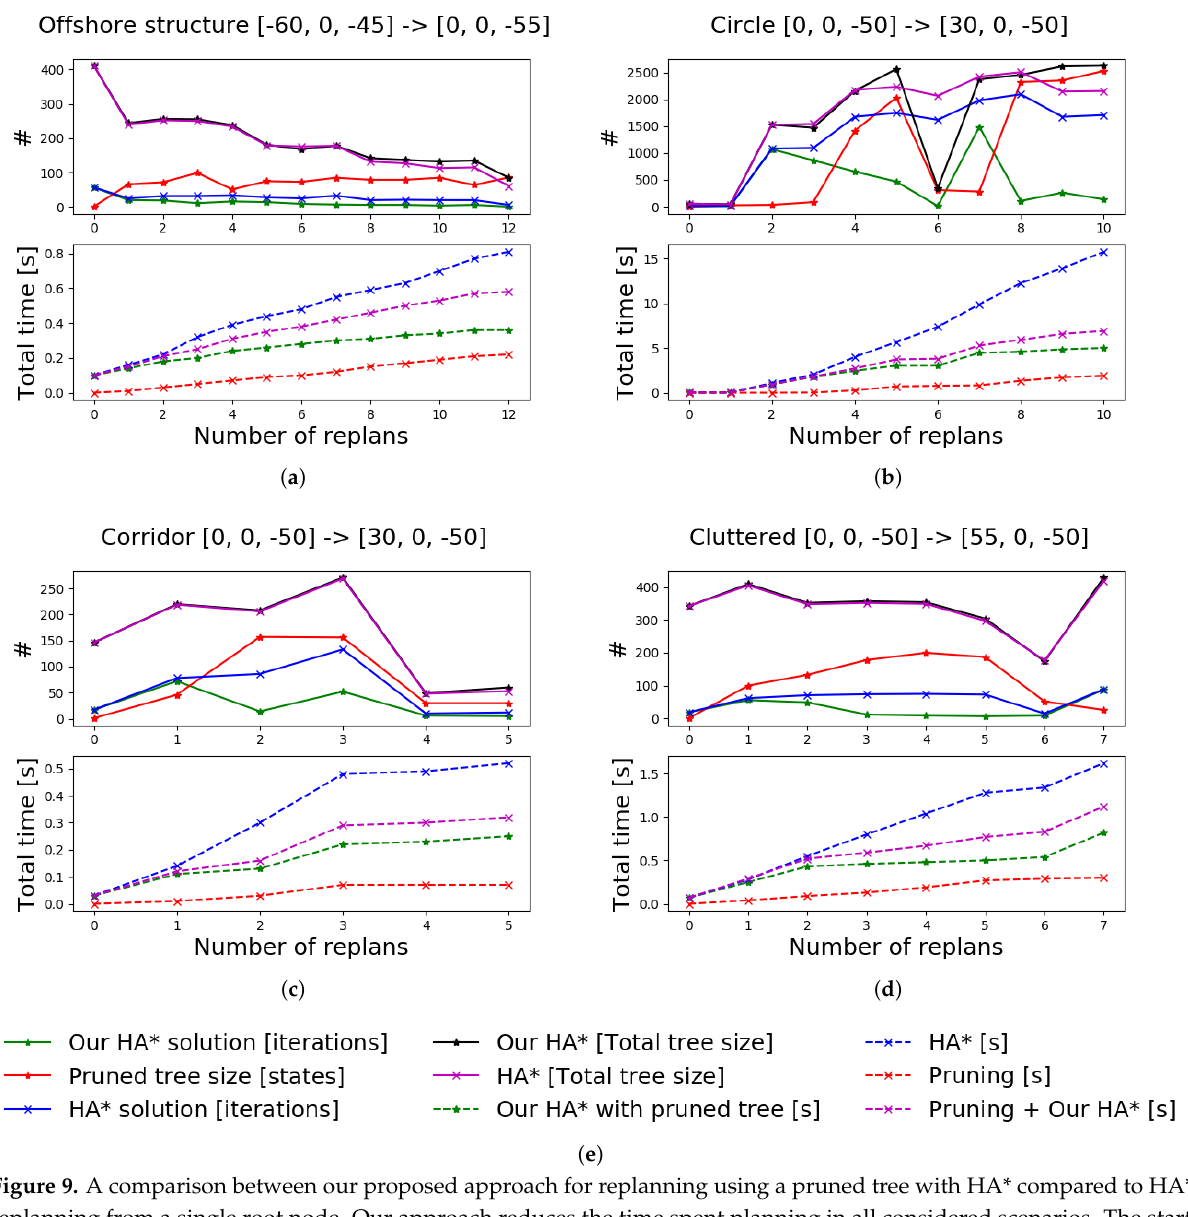
Figure 9. A comparison between our proposed approach for replanning using a pruned tree with HA* compared to HA* replanning from a single root node. Our approach reduces the time spent planning in all considered scenarios. The start position of the robot and the goal are presented, for each scenario, above the corresponding graph. ( a ) Scenario 1: offshore structures. ( b ) Scenario 2: circle/narrow exit. ( c ) Scenario 3: corridor. ( d ) Scenario 4: incident/cluttered. ( e ) Legend to describe the